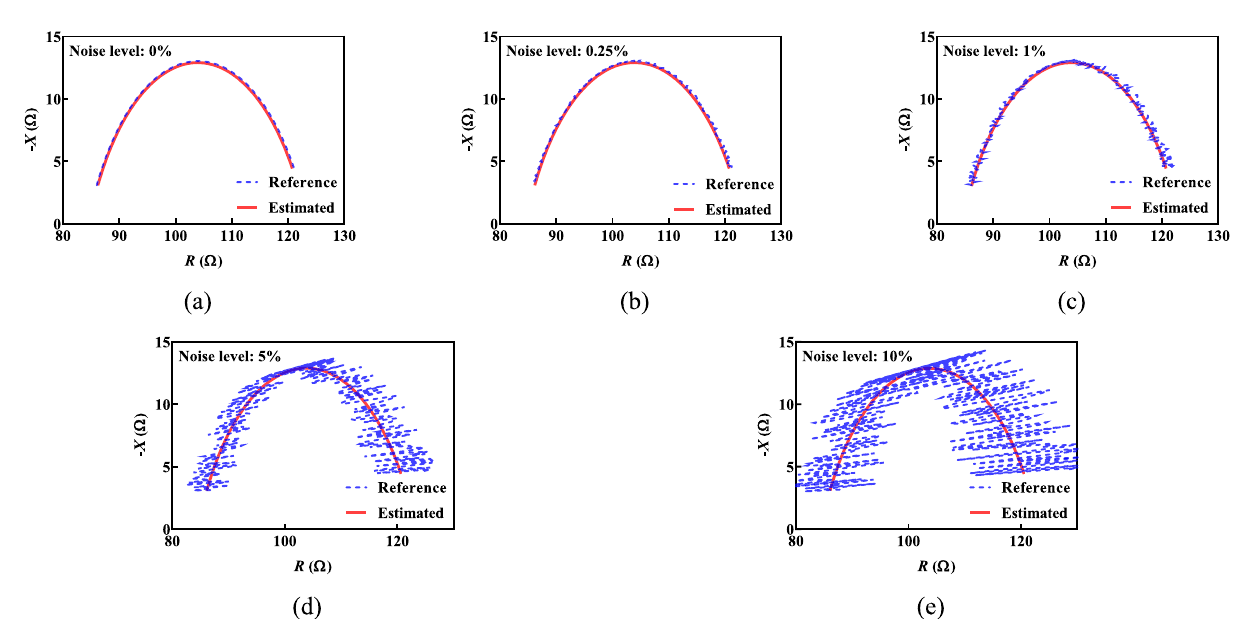
Figure 3. The Nyquist plots of reference and estimated values for five different noise levels: ( a ) 0%, ( b ) 0.25%, ( c ) 1%, ( d ) 5% and ( e )